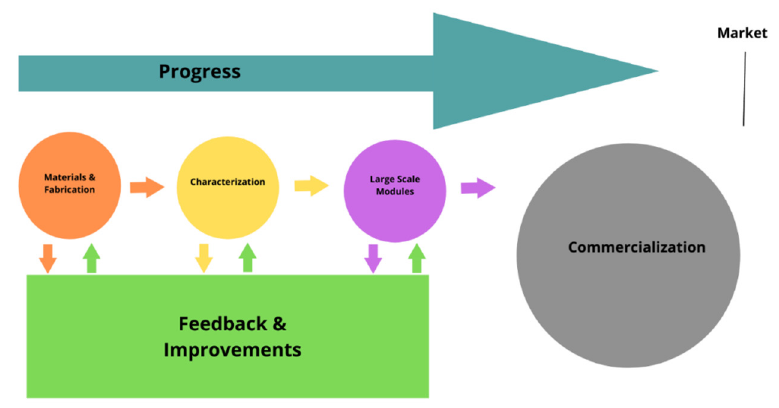
Figure 10. Scheme of the progress of perovskite tandem PVs.